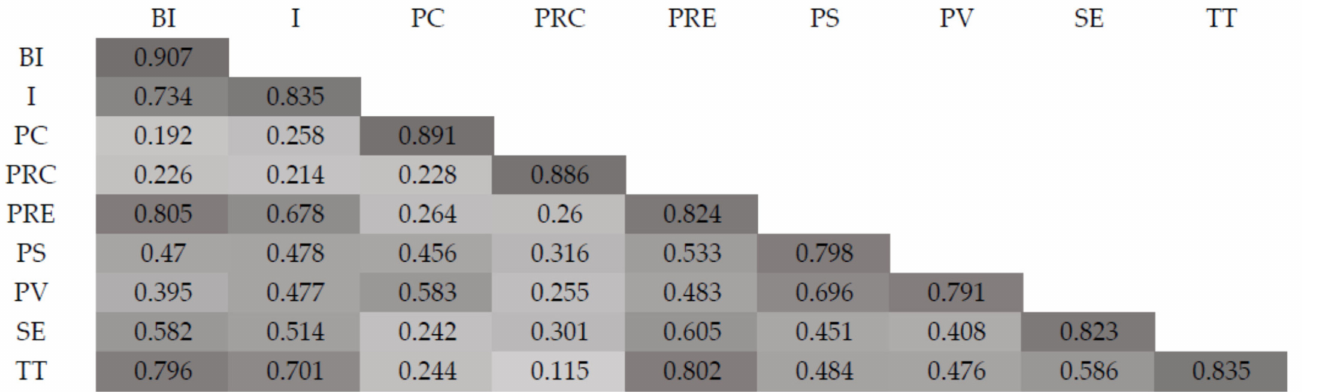
Table 2. Direct effects, total indirect, and total effects β of determinants of intention to use BBCA technology. Path Direct Effects β t-Value R 2